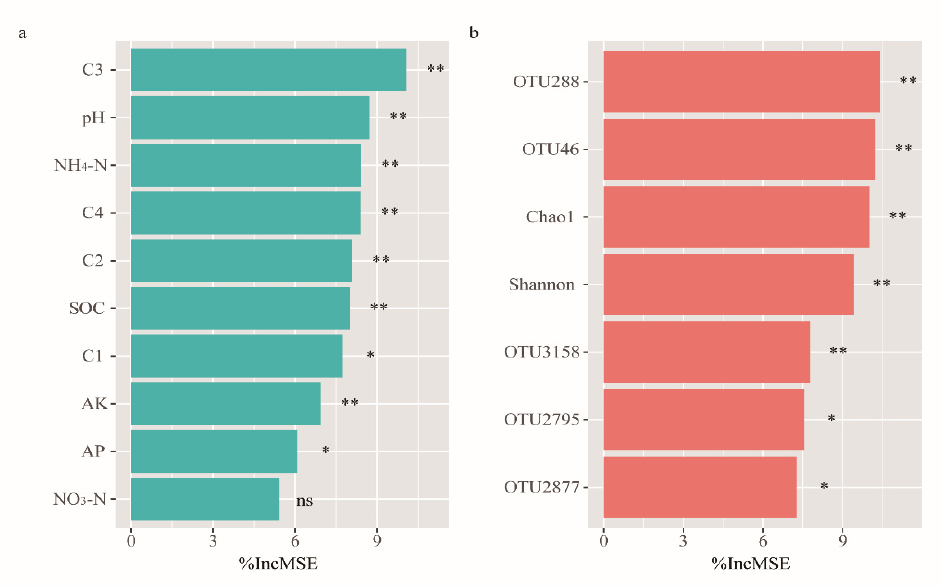
Figure 5. Random forest analysis showing the relative contribution of ( a ) Soil properties and ( b ) fungal community in determining the CMI. The fungal community data represent alpha indices (Shannon and Chao1) and relative abundance of keystone taxa (for each OTU in Table S2). ** p ≤ 0.01; * p ≤ 0.05; ns p > 0.05. IncMSE—the increase in mean square error.